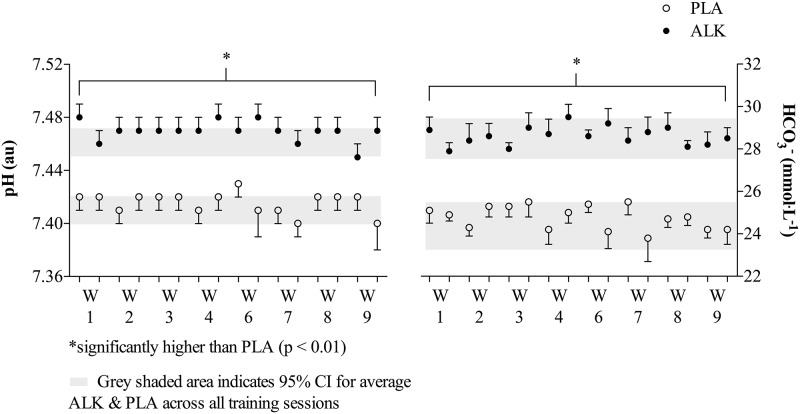
Pre-training blood pH and bicarbonate (HCO3-) values for each of the four training sessions throughout the 10-wk training program.Two alkalosis (ALK) and two placebo (PLA)) within the weekly training cycle (e.g. Wk 1, Wk 2, etc.), data are mean ± SEM.